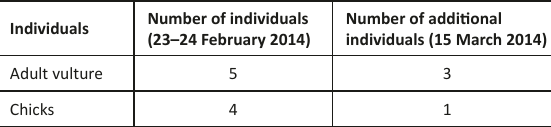
Table 1. The Long-billed Vultures observed during both the